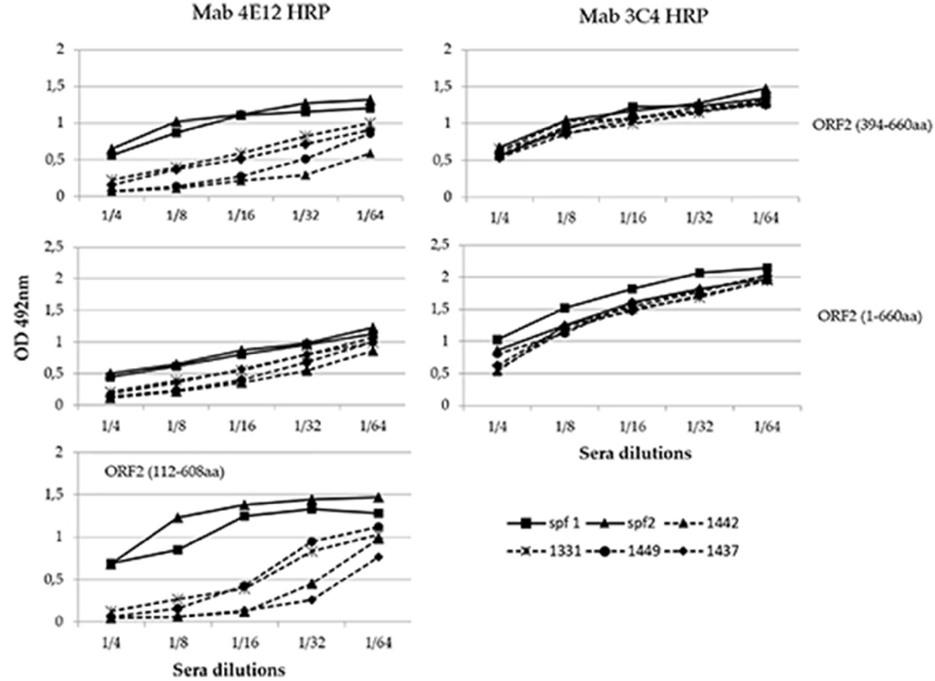
Figure 6. Competition profile of four positive sera (1331, 1437, 1442, and 1449) and two negative controls (spf1 and spf2) with MAb 4E12 and controls (spf1 and spf2) with MAb 4E12 and 3C4.